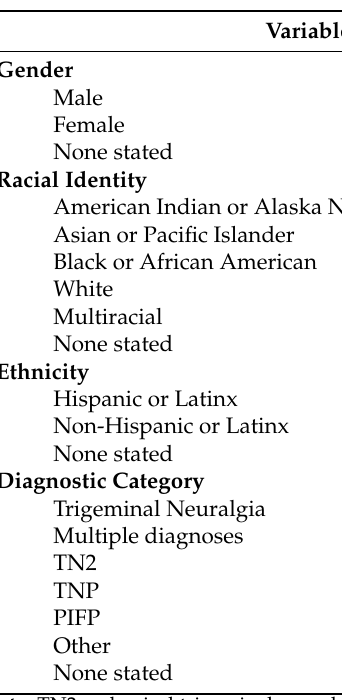
Table 1. Participant